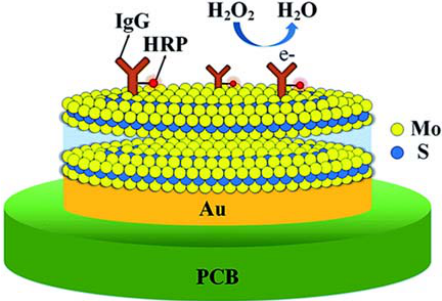
Figure 9. Schematic of the MoS 2 biosensor device. For biosensing, the MoS 2 is functionalized with receptors for specifically capturing target biomolecules. Image adapted from [62]; published by The Royal Society of Chemistry.